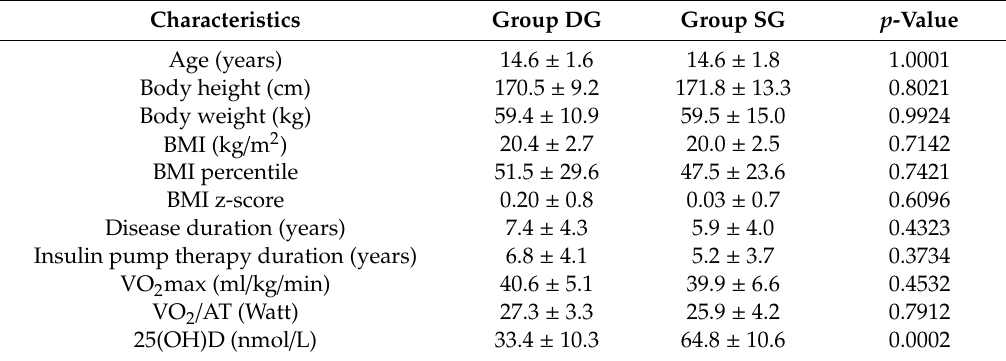
Table 1. Characteristic of the